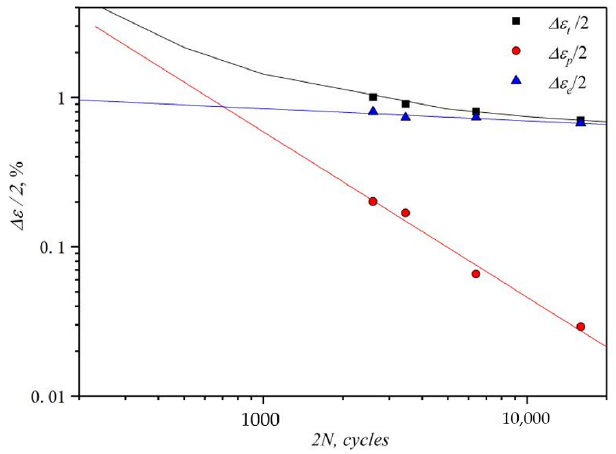
Figure 8. Number of half ‐ cycle reversals vs. strain amplitude in log–log coordinates.